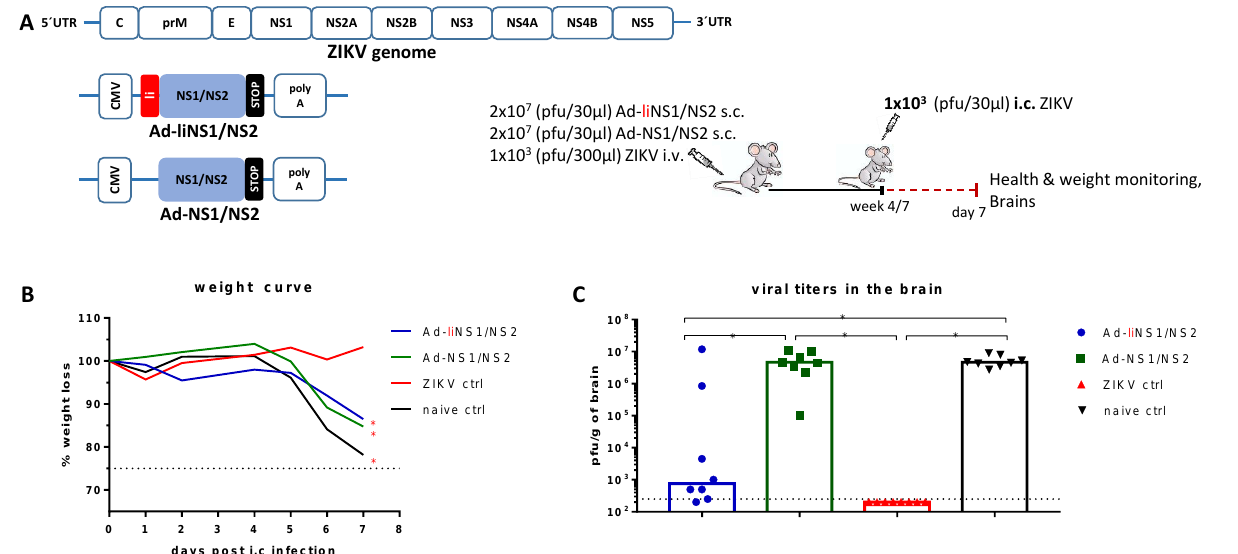
Figure 1. Level of protection conferred by Ad-liNS1/NS2 and Ad-NS1/NS2 vaccines. ( A ) Graphical representation of the ZIKV genome organization and the ZIKV proteins (NS1/NS2) encoded by the recombinant adenoviral vectors, with and without li-linkage, under the control of the Cytomegalovirus (CMV) promoter. ( B ) WT C57BL/6 mice were vaccinated s.c. with 2 × 10 7 pfu of either vaccine (Ad-liNS1/NS2 and Ad-NS1/NS2) and four or seven weeks later, these mice, along with ZIKV-immune and naive mice, were challenged i.c. with 1 × 10 3 pfu ZIKV. Mice were weighed and monitored daily. ( C ) On day 7 post i.c. challenge, brains were removed and viral titers were determined by a standard plaque assay. The detection limit for virus in brain was 250 pfu/g organ and is displayed as a stippled line. Each dot represents an individual animal. The columns represent the group medians and data are pooled from two independent experiments. * p < 0.05. For the weight curves, error bars were omitted for clarity, instead, stars denote a statistical significant difference compared to the unvaccinated control